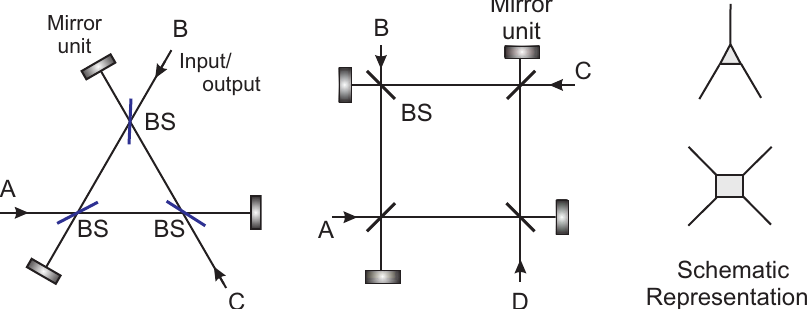
Figure 7. The directionally-unbiased three-port ( left ) and four-port ( middle ). The rectangles after the beam splitters represent a vertex mirror unit consisting of a mirror and a phase-shifter. The distance between each beam splitter and the adjacent mirror unit is half the distance between two adjacent beam splitter. Right figure: more schematic representations of the three- and four-port units as optical scattering vertices that connect to three or four external legs for use in optical graphs or networks.